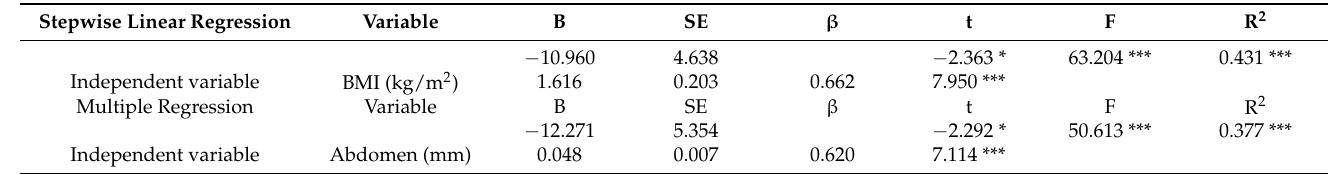
Table 4. Stepwise linear regression and multiple regression analysis results for ANIR in relation to anthropometric